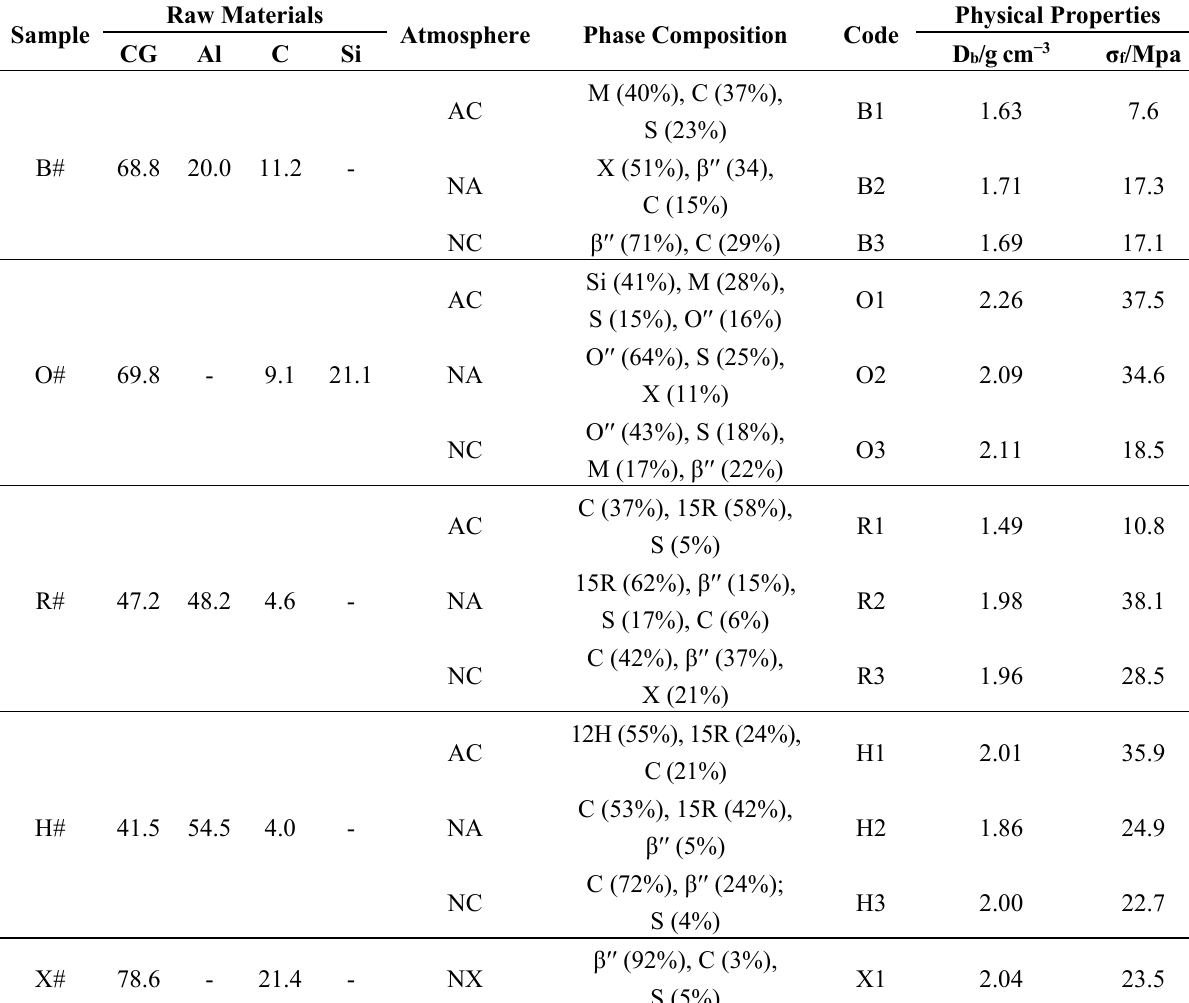
Table 3. Phase composition of samples (T = 1800